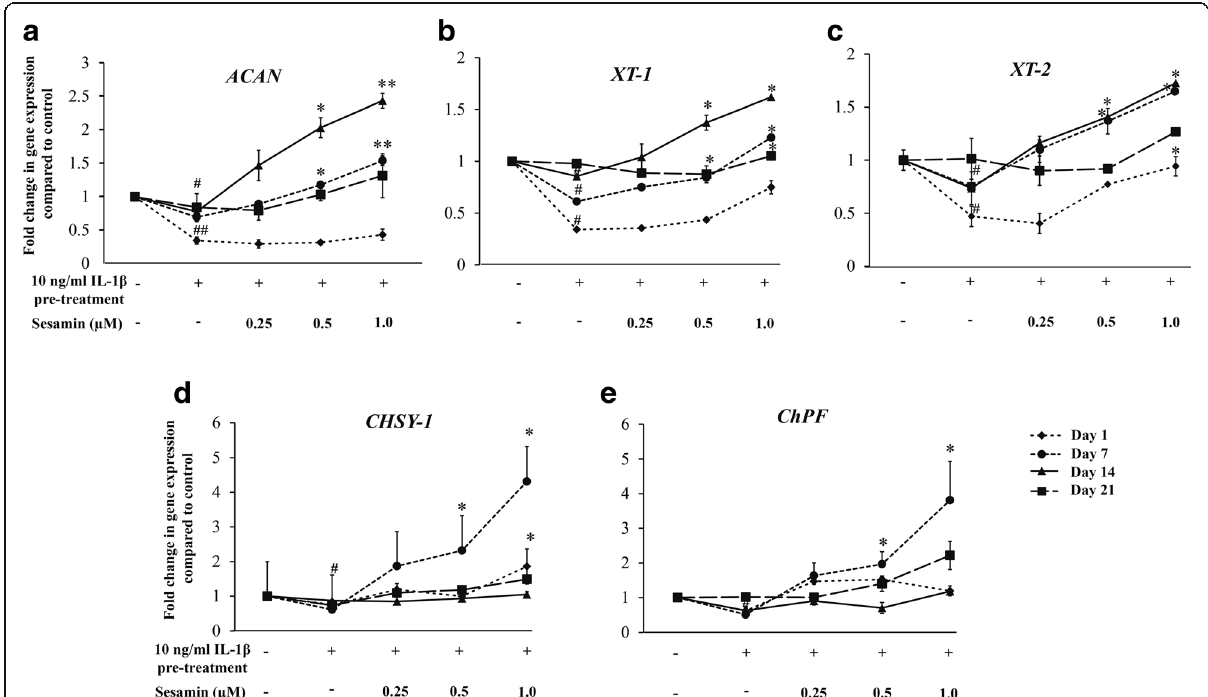
Fig. 3 Effects of sesamin on CSPG synthesis gene expression in IL-1 β pre-treated HAC pellets over 21 days: ACAN (Panel a ), XT-1 (Panel b ), XT-2 (Panel c ), CHSY1 (Panel d ) and ChPF (Panel e ). Data presented are the mean ± S.D. of three independent cultures. Statistical significance in com- parison of IL-1 β pre-treatment alone vs untreated (control): # = p < 0.05 and in comparison of sesamin treatment vs IL-1 β pre-treatment alone: * = p <